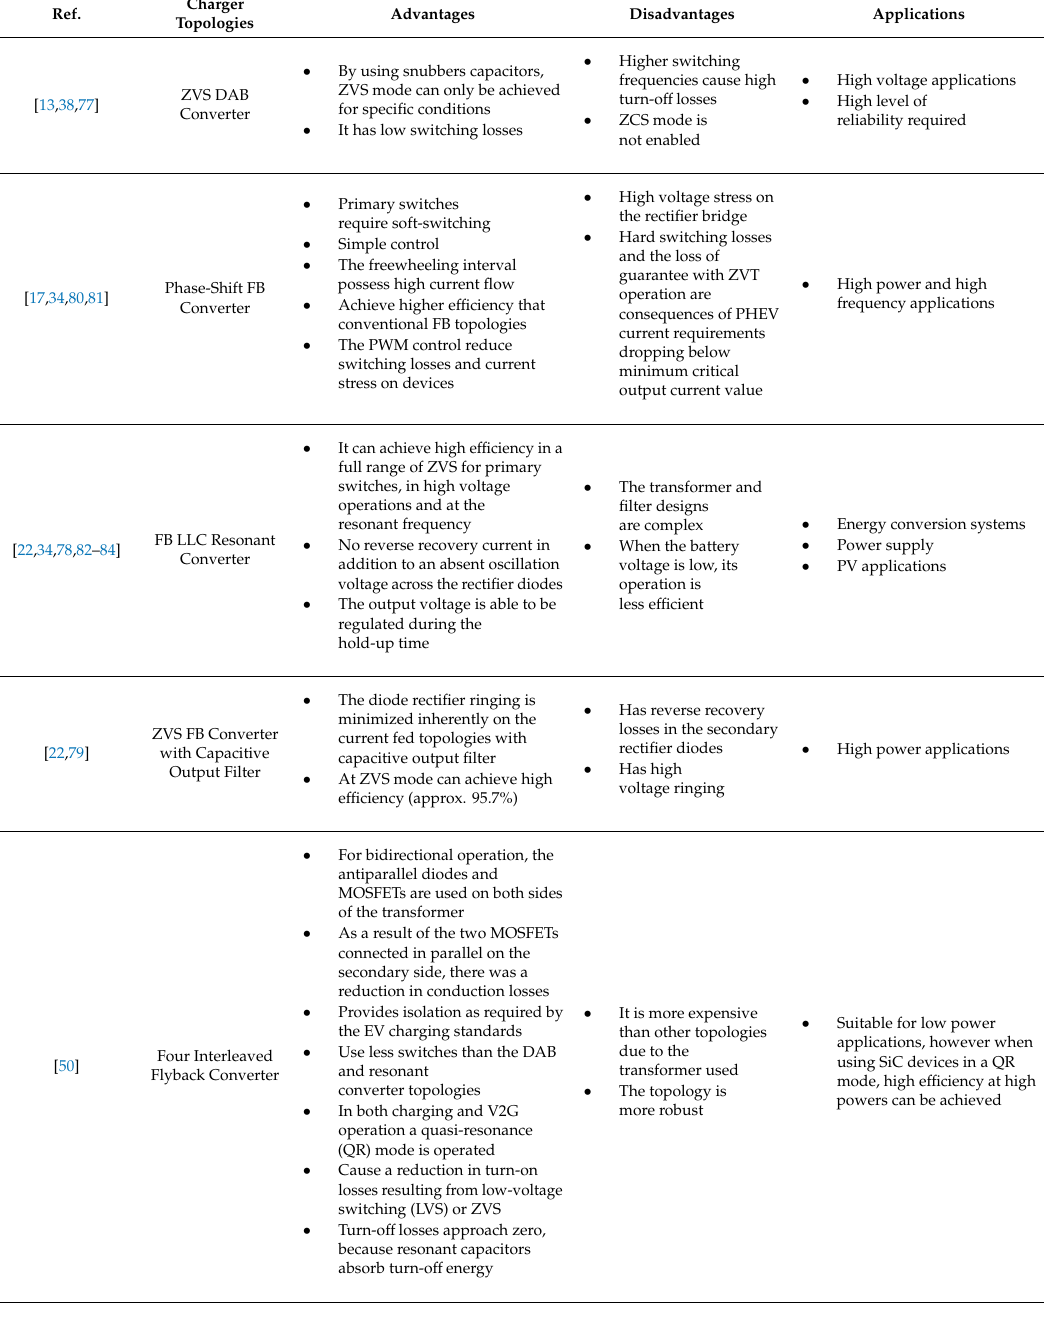
Table 5. Comparison of isolated bidirectional DC–DC converter topologies.